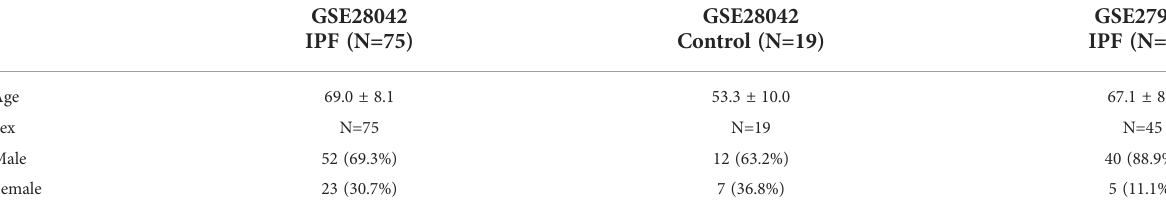
TABLE 1 Basic information of the patients in GSE28042 and